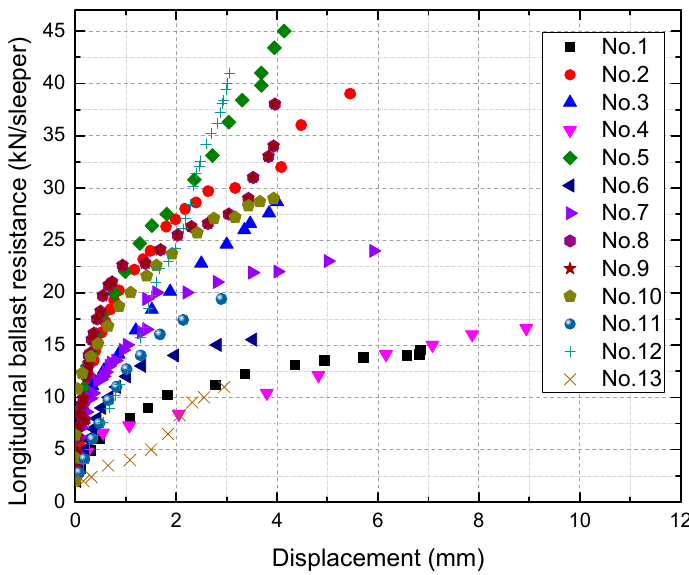
Figure 5. Longitudinal ballast resistance versus displacement.